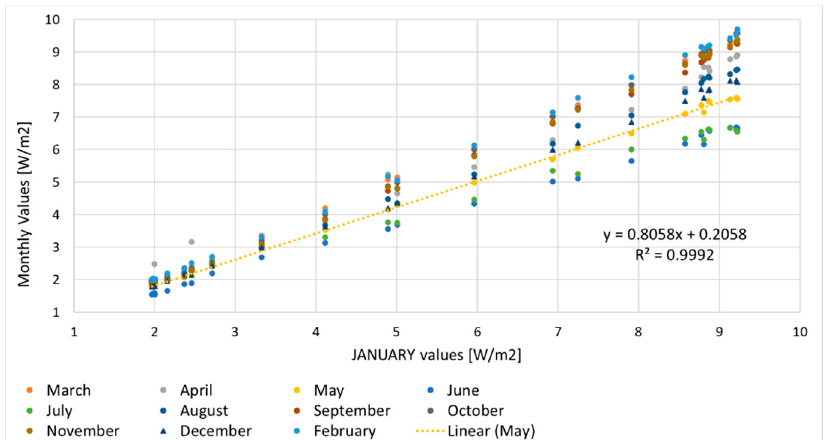
Figure 17. Linear correlation for the 12 months, weekdays.